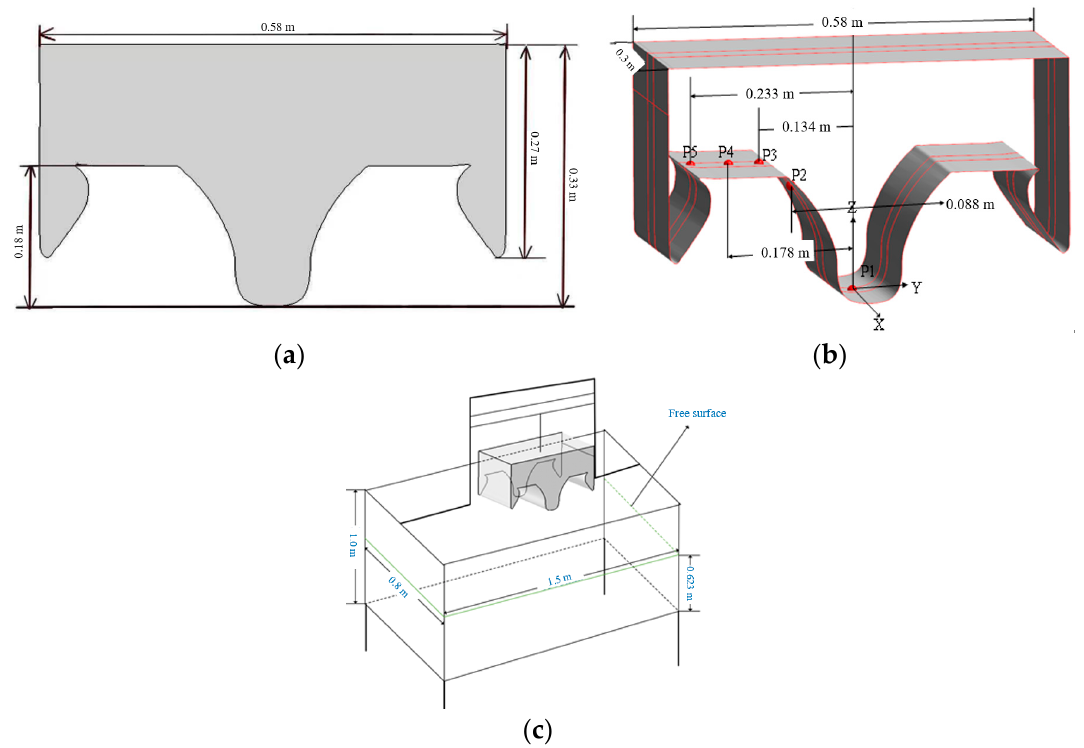
Figure 1. Dimensions of trimaran model and schematic diagram of experimental setup (( a ) Sketch of trimaran model; ( b ) Hull dimensions and pressure sensors layout; ( c ) Schematic diagram of experimental layout).